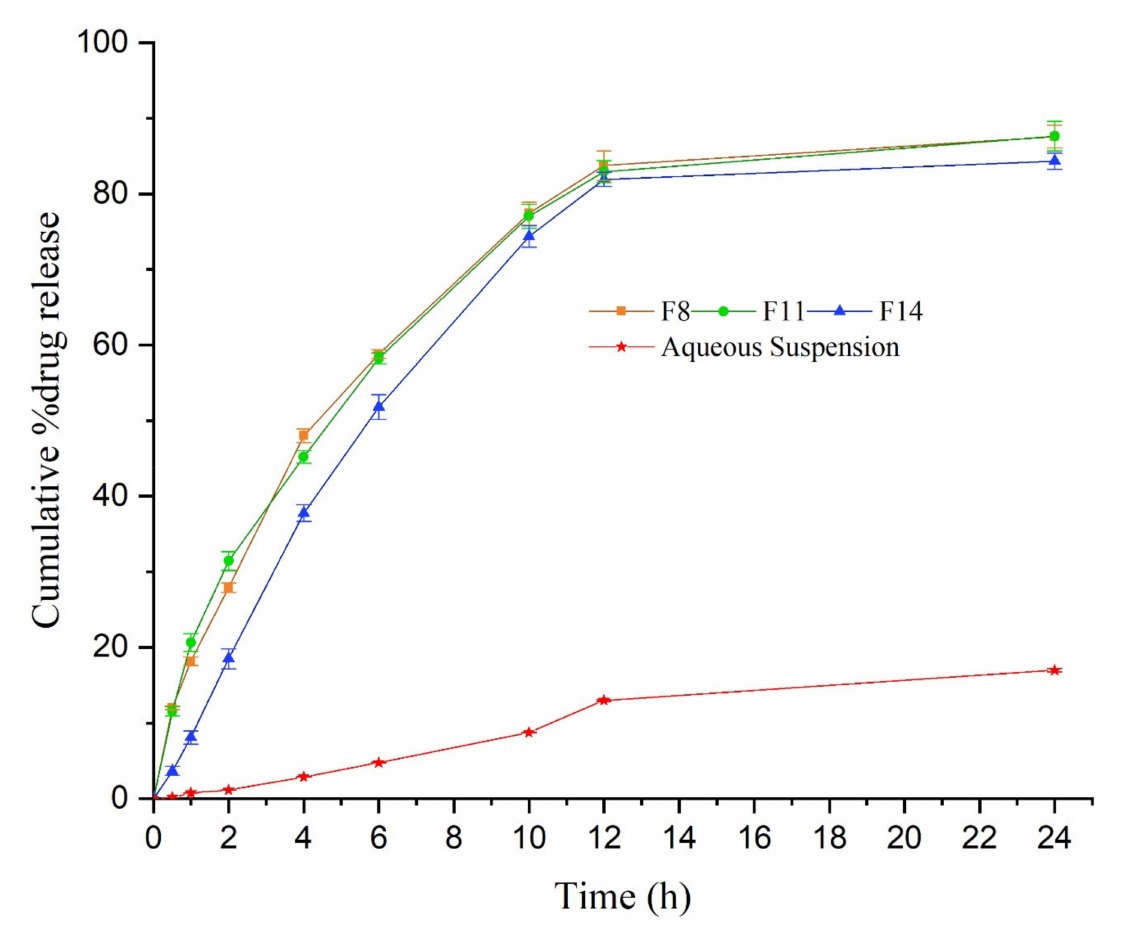
Figure 3. In-vitro drug release from TMQ-loaded NE